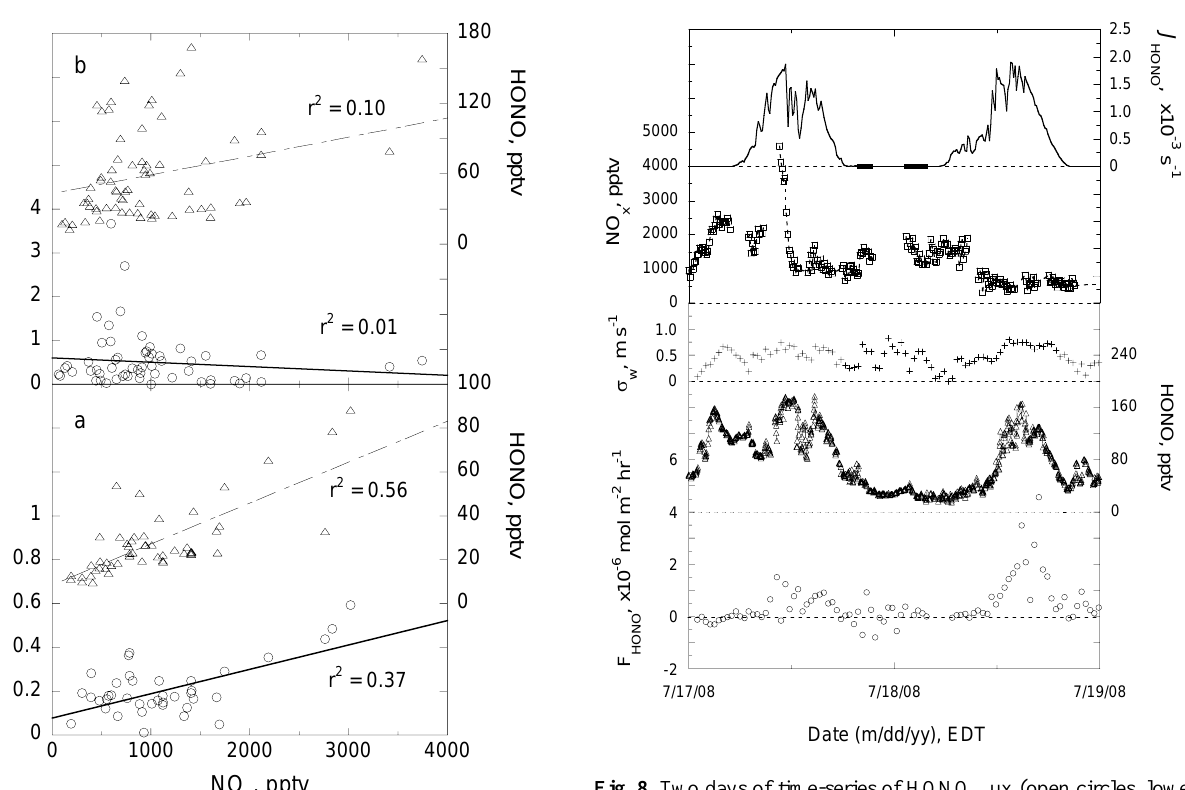
Fig. 8. Two days of time-series of HONO flux (open circles, lower panel, left axis), ambient HONO concentration (open triangles, lower panel, right axis), σ w (crosses) and NO x (open squares, upper panel, left axis), and J HONO (line, upper panel, right axis). The two thick horizontal lines at J HONO = 0 in the upper panel indicate two periods of light